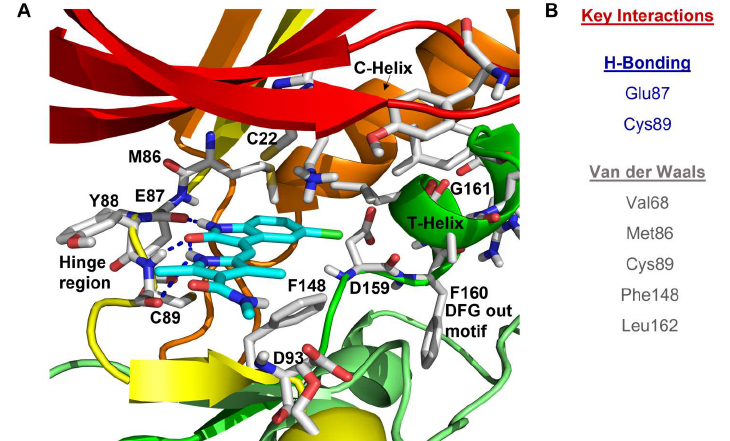
Figure 7. ( A ) SU11652 inhibits Nek2 by occupying the backside of ATP-binding cleft and forming a network of polar and non-polar interactions with the vicinal amino acid residues of the protein. (PDB code: 2JAV). ( B ) The enlisted amino acid residues engage with the ligand using both polar (H- bonding) and non-polar (van der Waals) interactions.